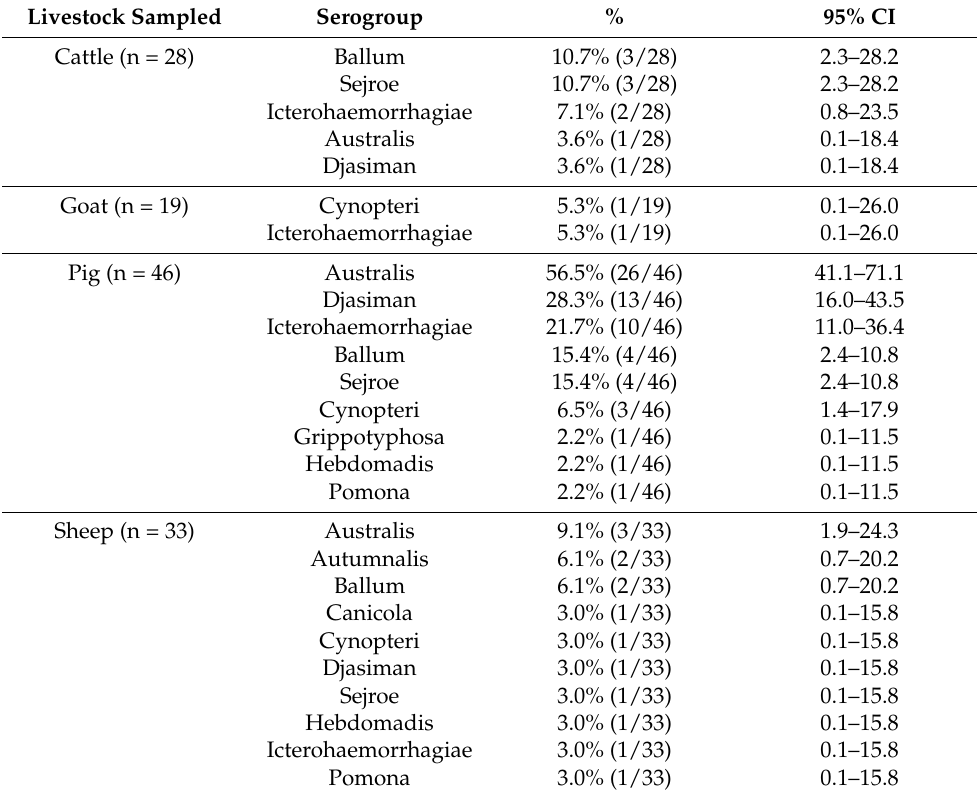
Table 2. Microscopic agglutination test (MAT) results by livestock species and serogroup detected and the associated confidence intervals †